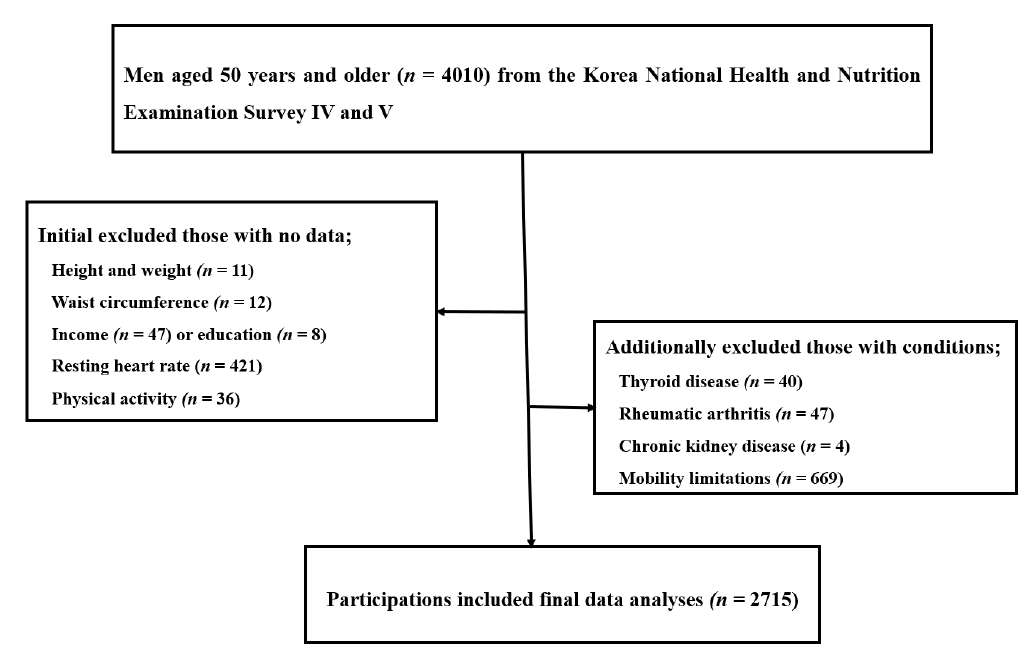
Figure 1. Selection of eligible study participants.